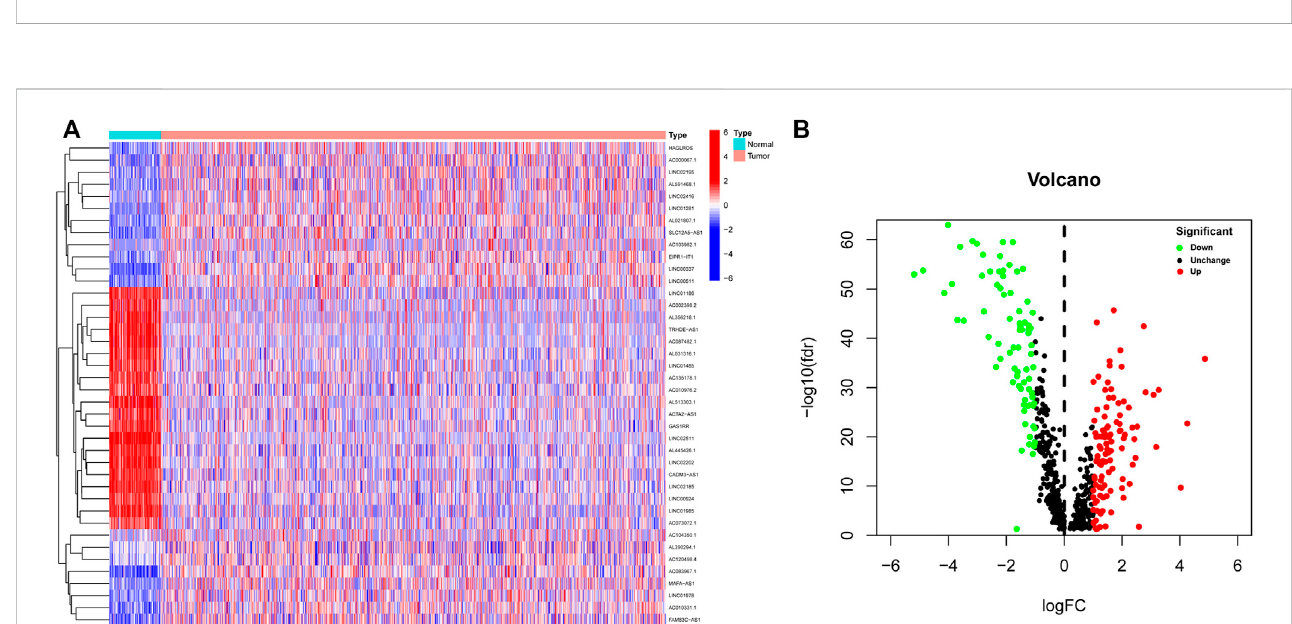
FIGURE 2 Identi fi cation of differentially expressed NETs-related lncRNAs in BC. (A) Heatmap demonstrating the differential expression of the top 20 up-regulated and 20 down-regulated NETs-related lncRNAs in BC tissues and normal tissues. (B) Volcano plot exhibiting 105 up-regulated and 81 down-regulated NETs- related lncRNAs. NETs, neutrophil extracellular traps; lncRNAs, long non-coding RNAs; BC, breast